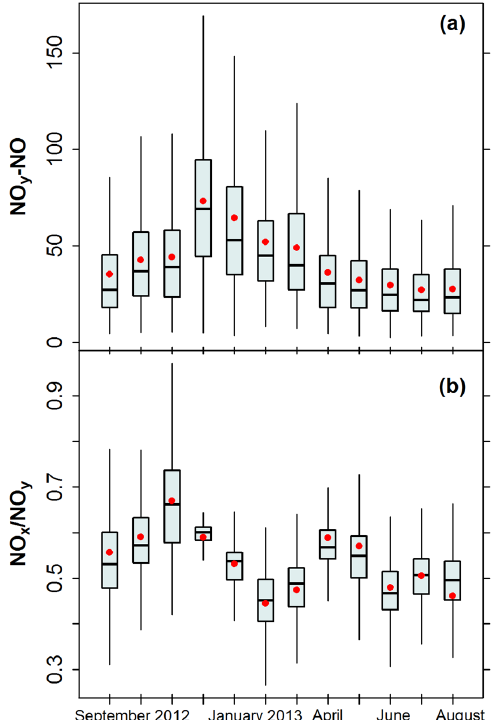
Figure 5. ( a ) Annual profile of the difference NO y –NO for data recorded at the OBI site from September 2012–August 2013; ( b ) NO x /NO y ratios during the same period. The horizontal black line shows monthly medians, and the red dots show monthly